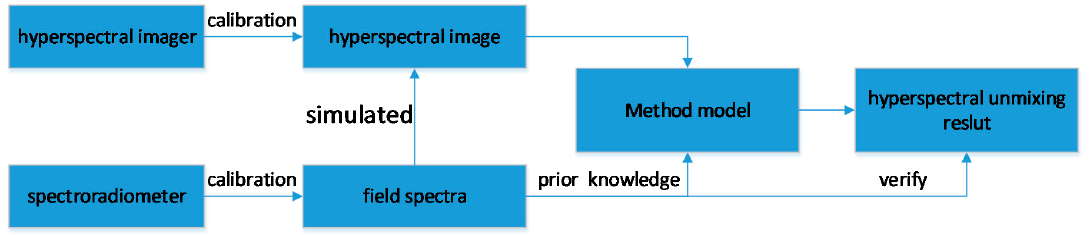
Figure 4. Data flow of acquisition and process.